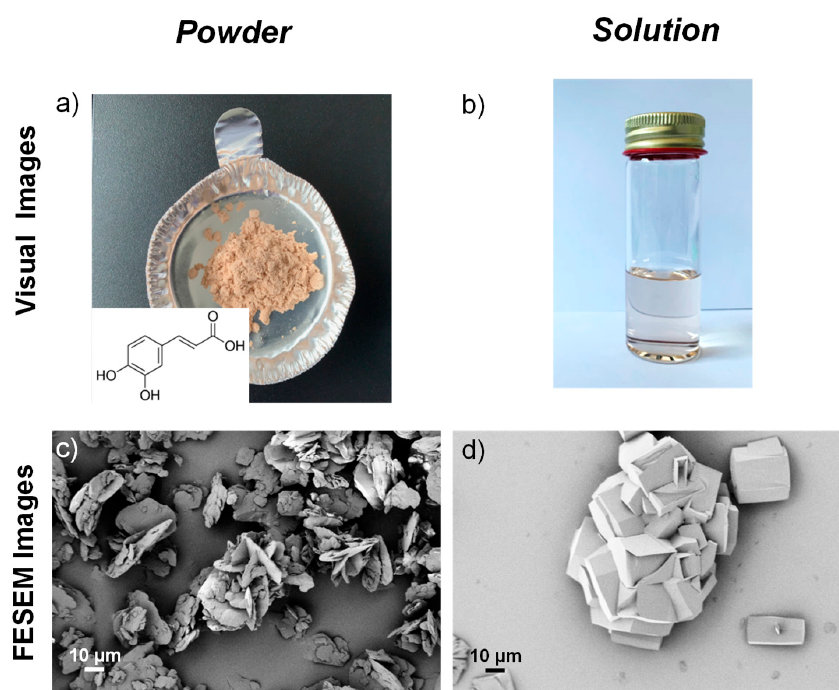
Figure 1. Visual images (chemical structure, see insert of visual image of ca ff eic acid (CA) powder) of Figure 1 . Visual images (chemical structure, see insert of visual image of caffeic acid (CA) powder) of CA powder ( a ) and solution ( b ). FESEM images of ca ff eic acid in powder ( c ) and after dissolution in CA powder ( a ) and solution ( b ). FESEM images of caffeic acid in powder ( c ) and after dissolution in 1-propanol / water solution ( d ). 1-propanol/water solution ( d ).